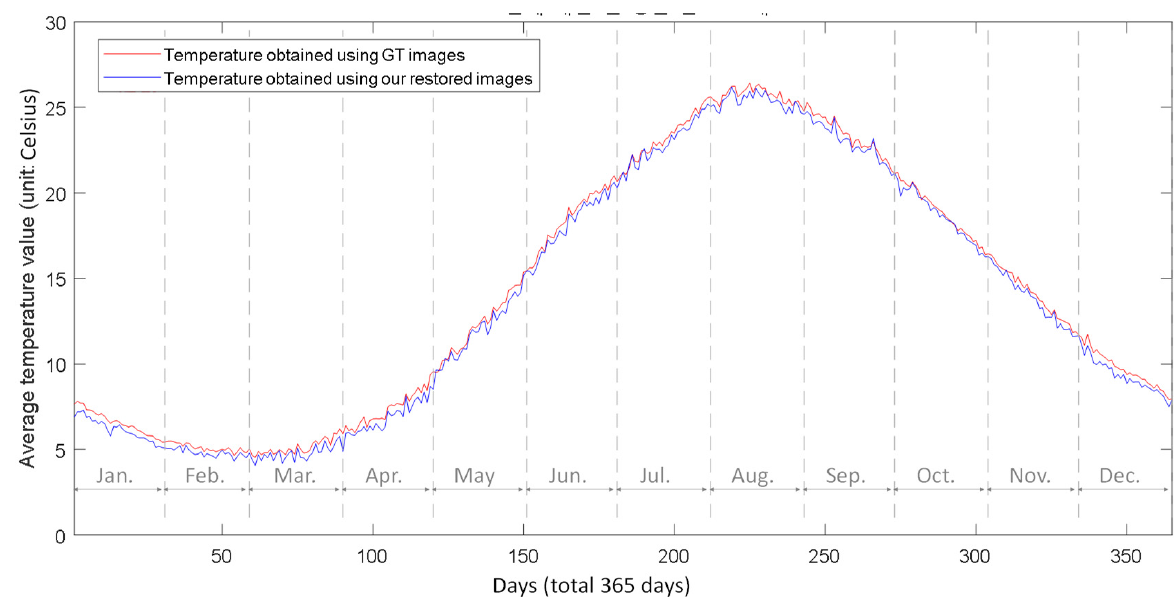
Figure 9. Plot of daily ocean surface temperature values within one year (365 days) for demonstrating restoration ability of the proposed GIN.